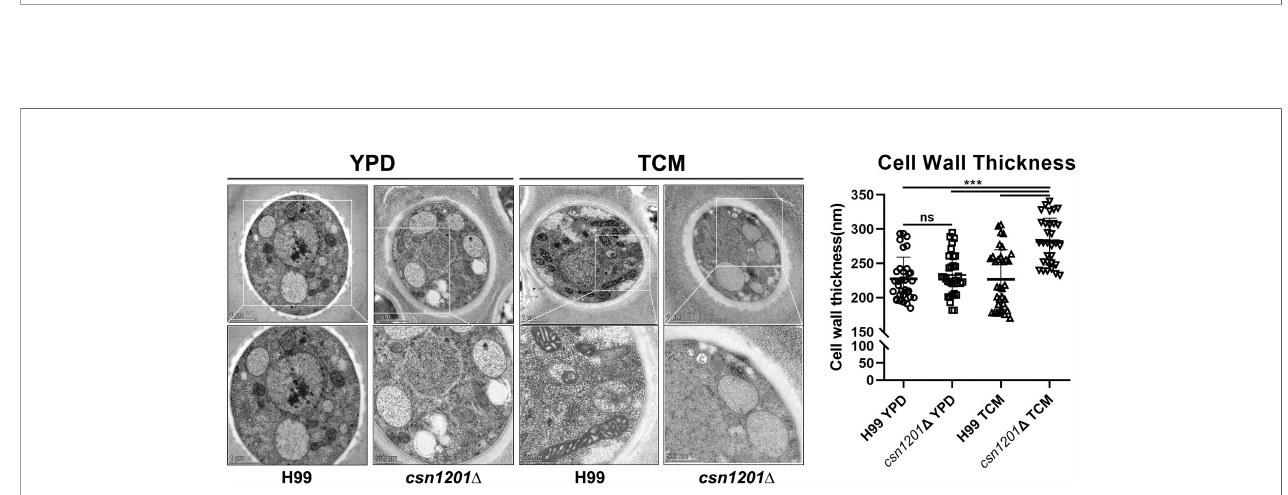
FIGURE 10 | Csn1201 regulates cell wall thickness of C. neoformans under host-relevant conditions. Transmission electron microscopy of both the WT and csn1201 D strains was carried out after incubation in either YPD medium or DMEM. ImageJ was utilized to quantify cell wall thickness. Results represent the mean ± SEM. ***, P < 0.001; ns, no signi fi cant